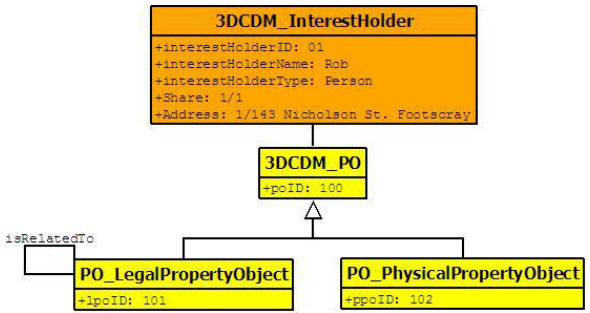
Figure 16. Instance of 3DCDM_InterestHolder Package